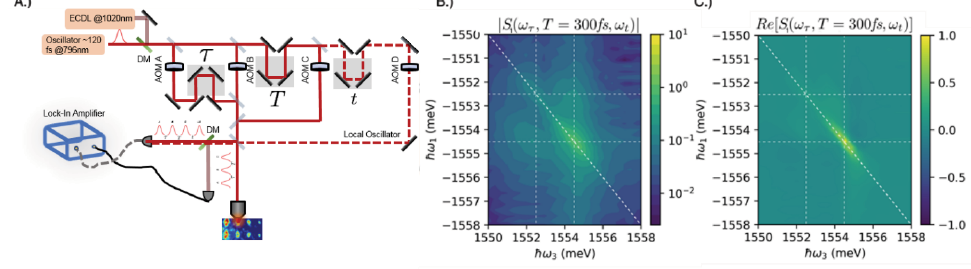
Figure 1: A.) Experimental apparatus showing two Mach-Zehnder interferometers nested within a larger interferometer. Each arm of the (cid:2) interferometer has an AOM driven at a unique radio frequency. At the interferometer entrance/output, both a Ti:Sapph. oscillator (at 796 nm) and a CW laser (at 1020 nm) are combined/split on a dichroic beamsplitter (DM). B.) Measured amplitude of a rephasing pulse sequence showing three orders of magnitude signal-to-noise. C.) Real part of rephasing pulse sequence demonstrating the recovery of the four-wave mixing